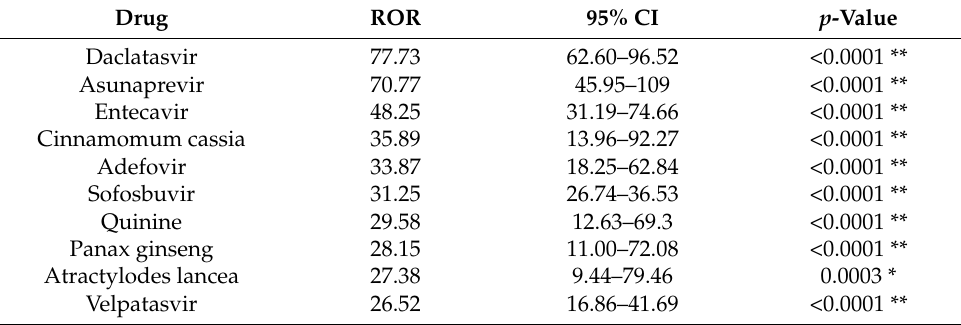
Figure 3. Drugs ( a ) and indications ( b ) associated with the development of LMT. The abscissa axis shows the natural logarithm of reporting odds ratios (lnROR); the vertical axis shows the common logarithm of inverse p -values ( − log10( p )) obtained by Fisher’s exact test. The dotted line on the y-axis represents a p -value of 0.05. The marker size and color spectrum from yellow to purple correspond to a + b from the contingency table, i.e., the number of reports of the use of the drug or the indication (diagnosis). Table 4. Top 10 drugs associated with the development of liver malignant